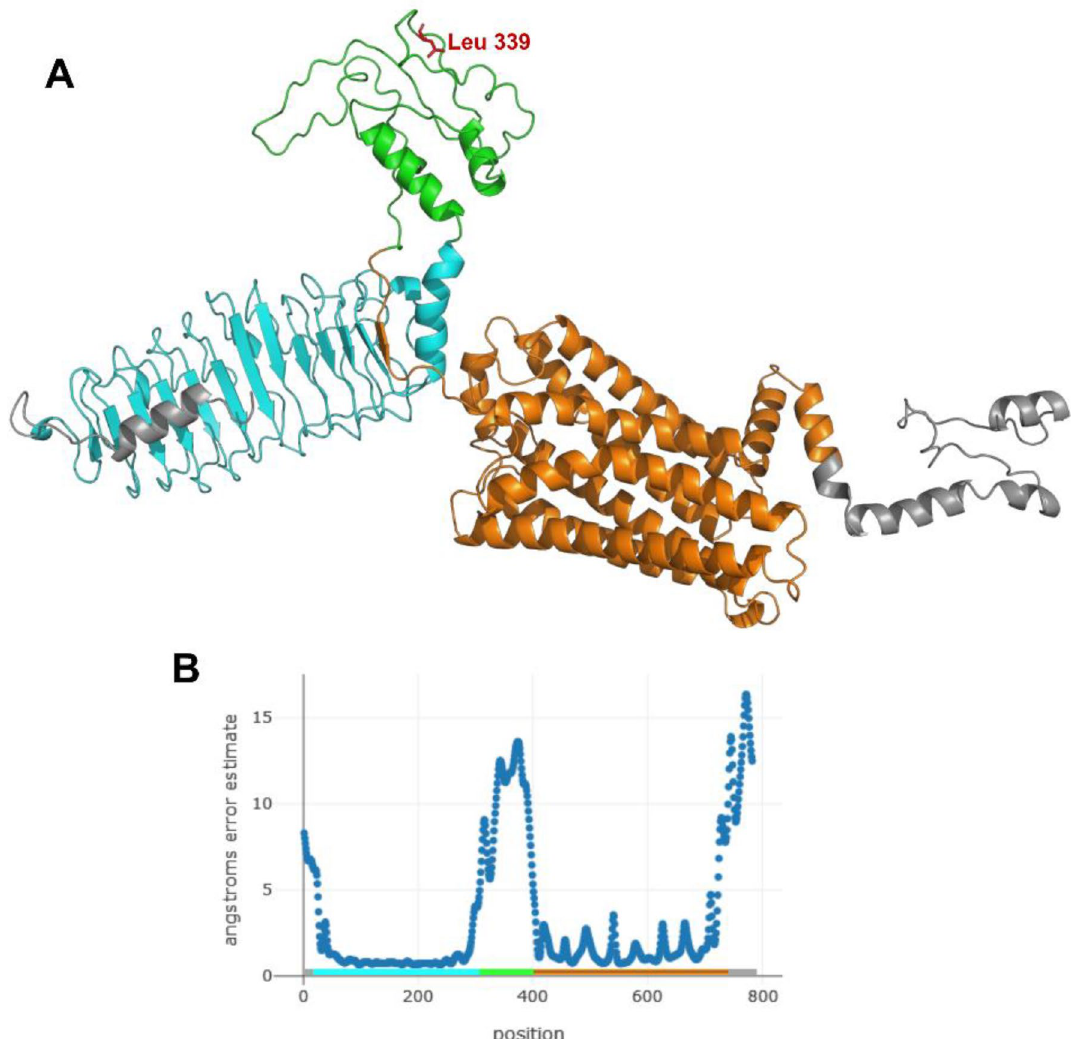
Figure 5. Structural model of turbot ( Scophthalmus maximus ) TSHR. ( A ) Cartoon representation of the hinge region (green) between the seven-parallel-helices domain (orange) and the leucine-reach-repeat domain (light blue). ( B ) Local quality of the model expressed in per-residue error